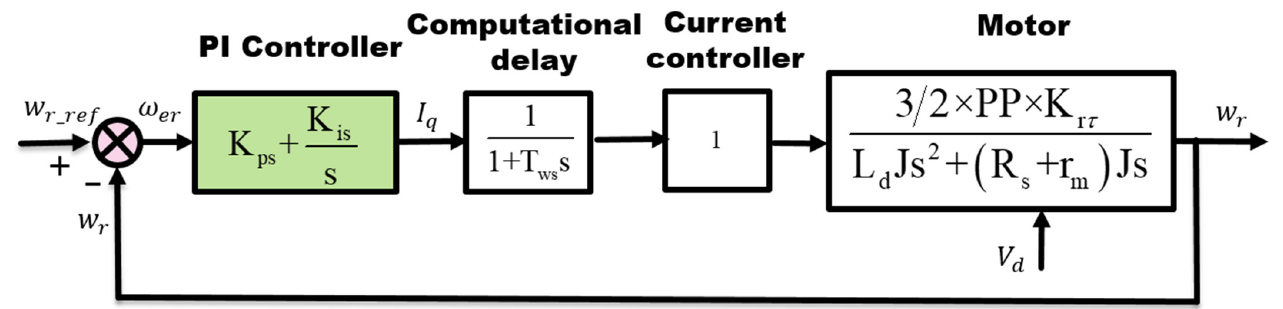
Figure 3. Closed-loop system diagram of outer speed control loop.